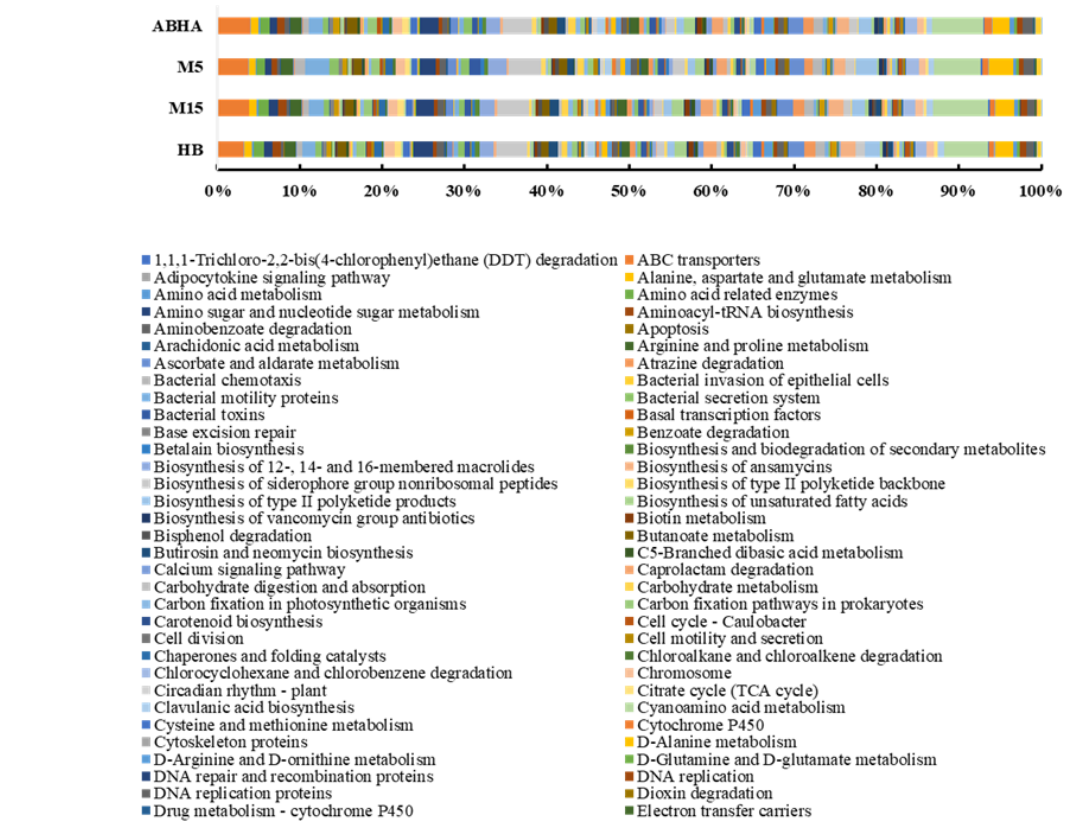
Figure 5. Predicted functional gene abundance in four different samples obtained through PICRUSt analysis. M5 and M15: samples collected from Muzahmiya, HB: sample collected from Hafar Al